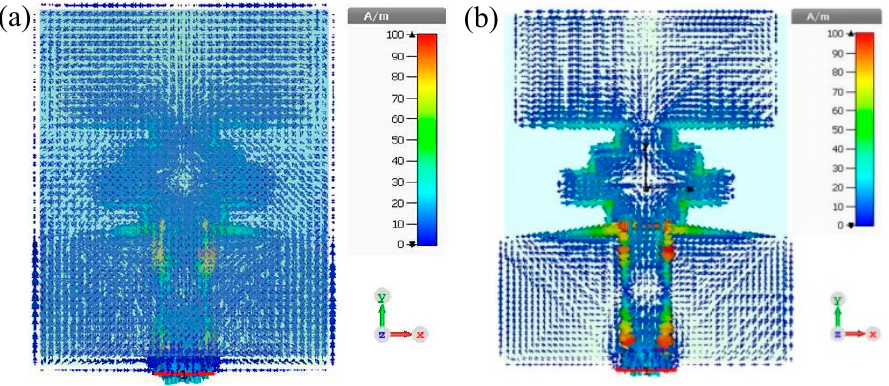
Figure 9. Current distribution of the antenna with OSC ( a ) and without OSC ( b ).